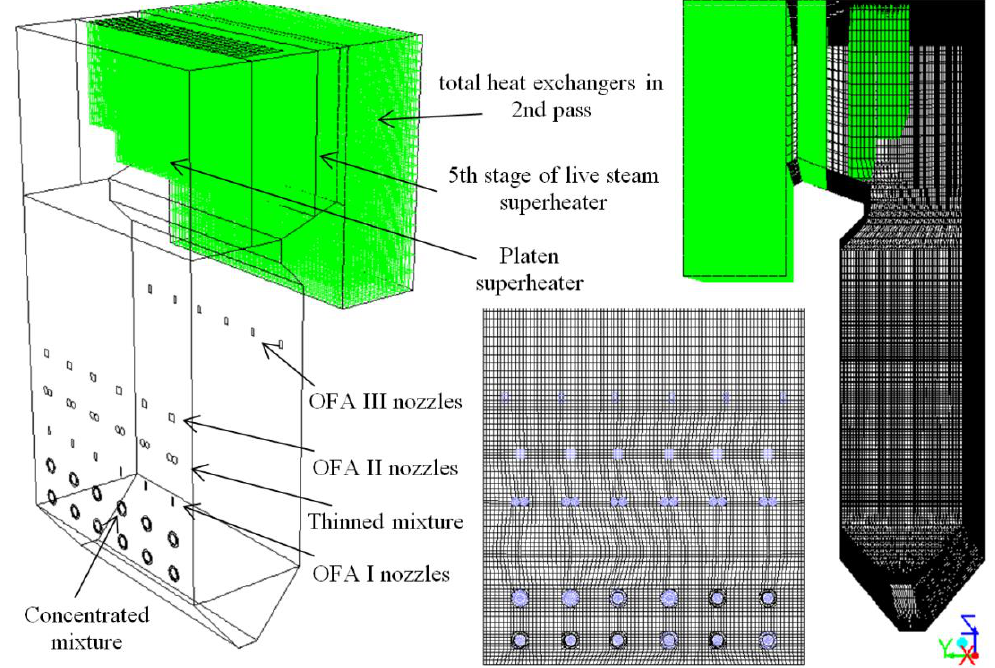
Figure 5. View of the boiler model geometry with description and the numerical mesh.